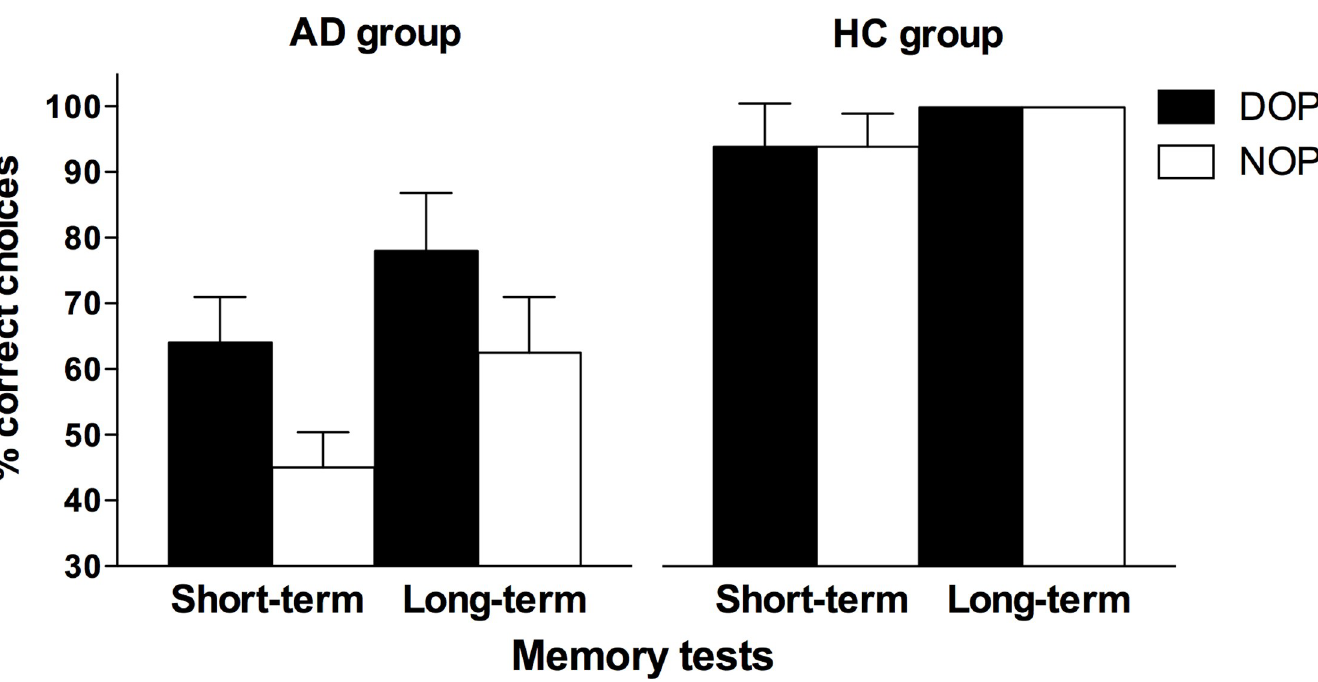
Fig 4. Mean percentages of correct responses obtained by participants in the memory tests as a function of retention interval (short and long), outcomes (DOP and NOP) and group (patients with Alzheimer’s disease–AD- and healthy controls–HC–). Error bars show the standard error of the